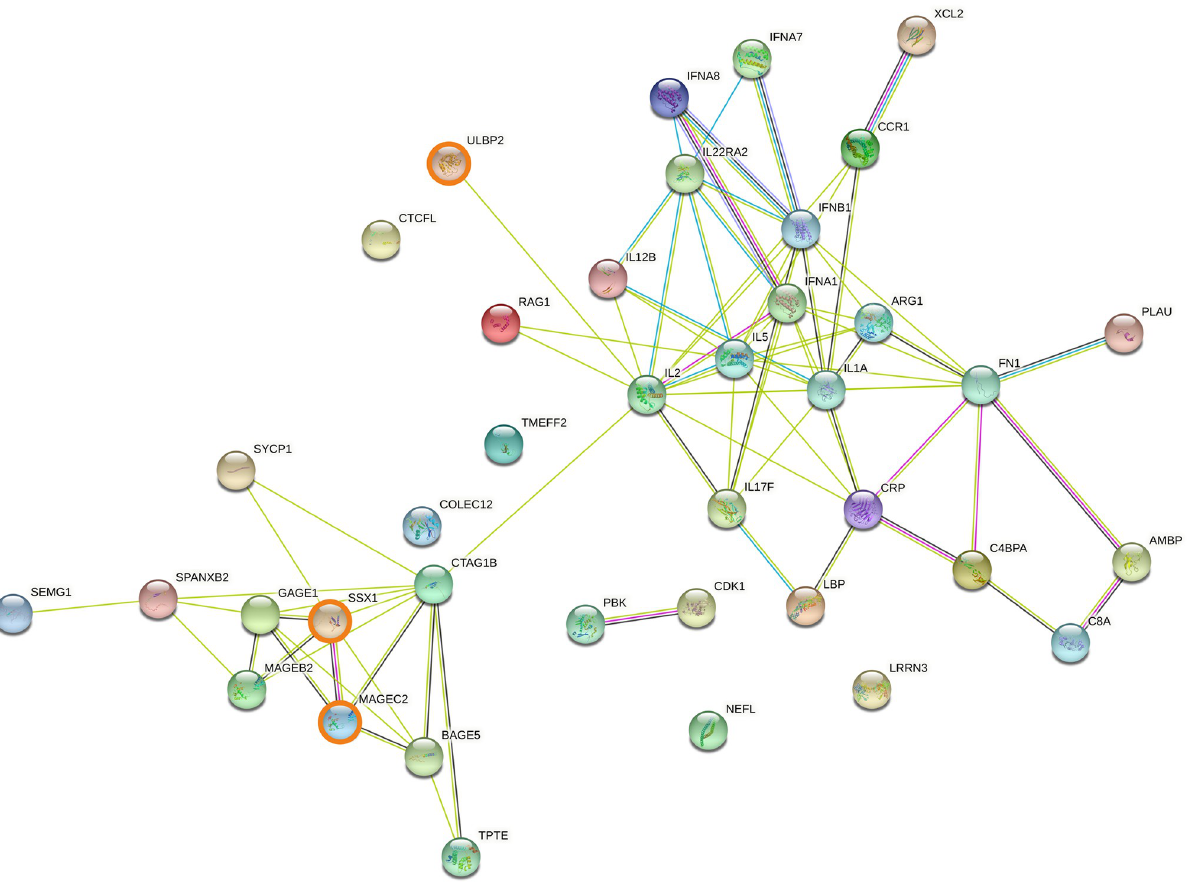
Fig 6. Protein association network analysis using STRING in all cancer patients. The predicted protein-protein interactions of significantly up- regulated genes (n = 39) in short survival cancer patients (FDR < 0.05, LogFC > 0.5) from the differential expression analysis incorporating both solid and blood cancer patients (n = 515). SSX1, MAGEC2 and ULBP2, the three genes found to be upregulated in both solid and blood patient cohorts, are shown in bold.